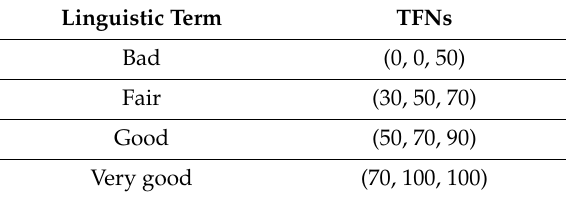
Table 2. Triangular fuzzy numbers (TFNs). Representatives of the semantic scale (source: authors’